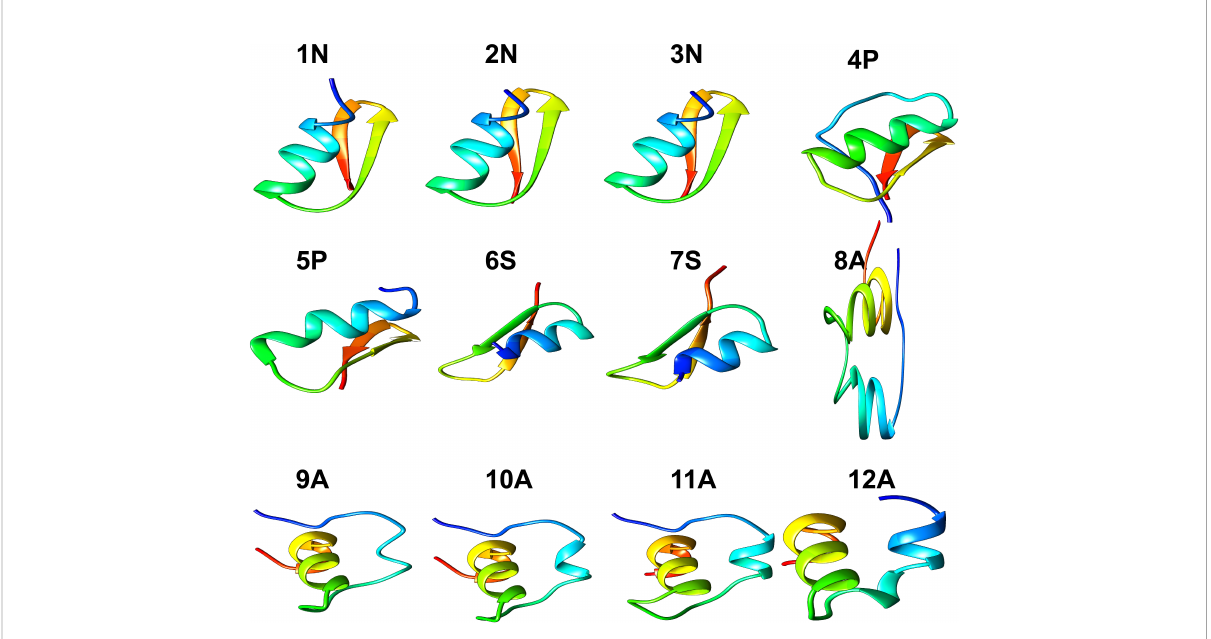
FIGURE 1 3D structure of peptides from 11 species of Cnidarians (shown in Table 1) with putative antimicrobial